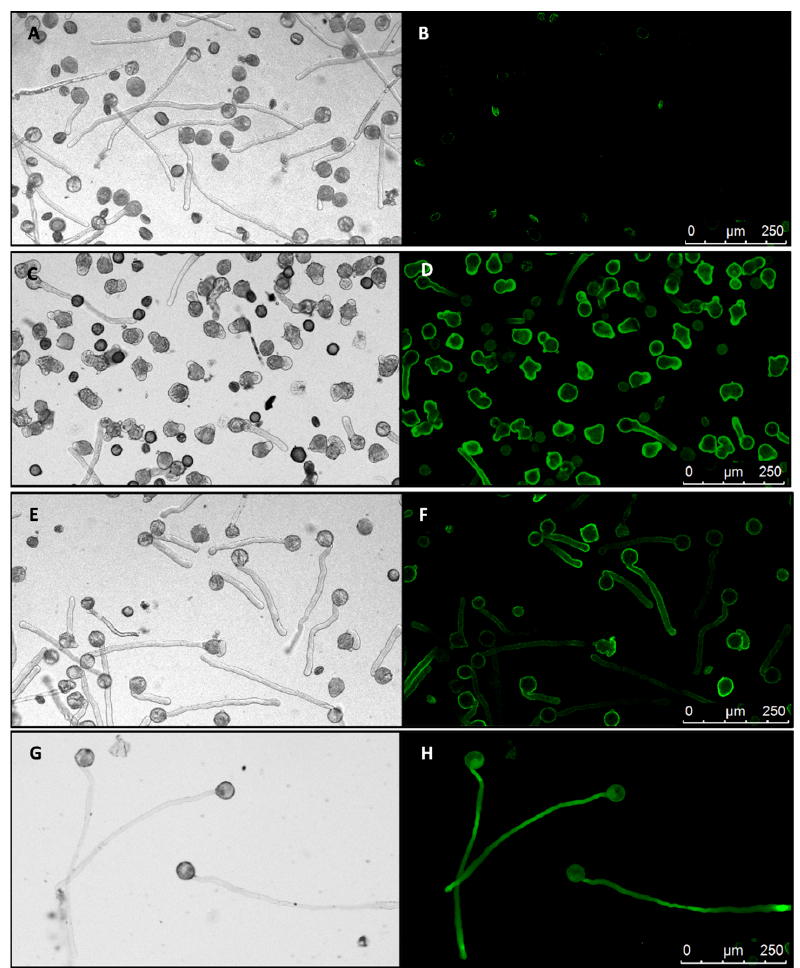
Figure 3. Effect of expressing PiCDPK1 alone and with PiRhoGDI1. Images show pollen cultured in vitro for 4 h at 28–30 °C. Paired images show light micrographs and equivalent fluorescence micro ‐ graphs (black background). ( A , B ), wild type pollen tubes, the slight fluorescence in ( B ) is associated with a low percentage of dead pollen which auto ‐ fluoresces. ( C , D ), pollen tubes from line OE1 (ho ‐ mozygous for Lat52 ‐ PiCDPK1 ‐ GFP alone) exhibiting loss of growth polarity (OE1). ( E , F ), pollen tubes from line Rescue 2 (homozygous for both Lat52 ‐ PiCDPK1 ‐ GFP and Lat52 ‐ PiRhoGDI1 ), these tubes did not lose polarity and resemble wild type pollen tubes. ( G , H ) from a homozygous p Lat52 ‐ GFP transgenic line showing pollen tubes expressing GFP alone. Transformants expressing PiRhoGDI1 were found to bear pollen 50% of which exhib ‐ ited loss of polarity and 50% grew in a polar manner, but 100% exhibited PiCDPK1:GFP fluorescence consistent with the pLat52 ‐ PiRhoGDI1 transgene being capable of rescuing loss of polarity caused by PiCDPK1. These plants were self ‐ pollinated, and the resulting seed used to generate a T1 population. From this population, lines were then identified for which 100% of the pollen exhibited both PiCDPK1:GFP fluorescence (indicating ho ‐ mozygosity for pLat52 ‐ PiCDPK1:GFP ) and grew in a polar manner (indicating homozy ‐ gosity for pLat52 ‐ PiRhoGDI1 ) (Figure 3E,F). Pollen from the various homozygous lines was cultured in vitro for 4 h and the phe ‐ notypes assessed. Pollen germination was not significantly different from wild type for any of the transgenic lines (Figure S3), in contrast there were significant differences in pollen tube phenotypes. Pollen expressing GFP alone grew with normal polarity to an